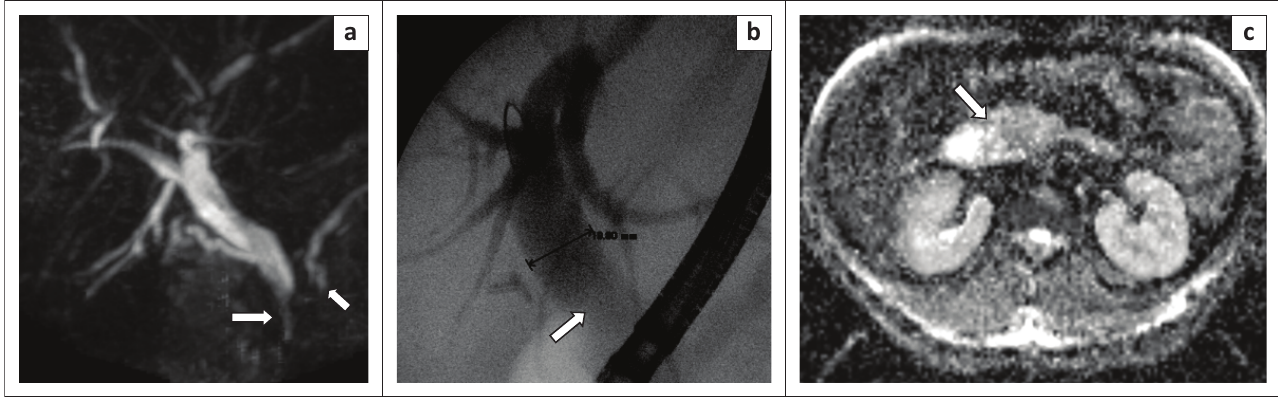
FIGURE 2: Forty-four-year-old woman with adenocarcinoma of the pancreas: (a) The double duct sign (arrows) is seen on MRCP image; (b) abrupt termination of the dilated common bile duct (arrow) is shown in ERCP image; (c) on the apparent diffusion coefficient image, there is a hypointense signal owing to diffusion restriction (arrow).